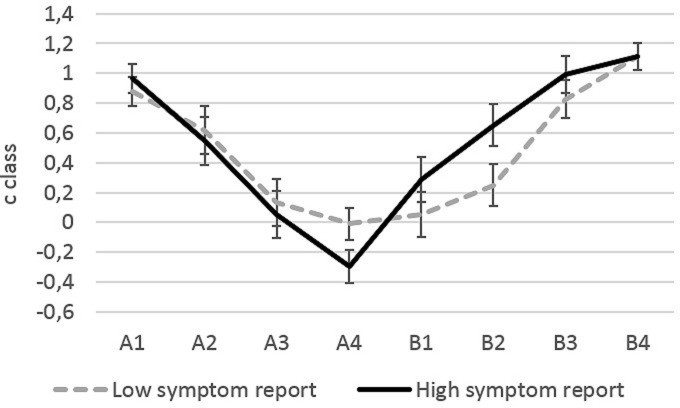
Cclass values calculated from z-transformed correct identification rates of a load as A or B and z-transformed false alarm rates. Error bars represent standard error of the mean.